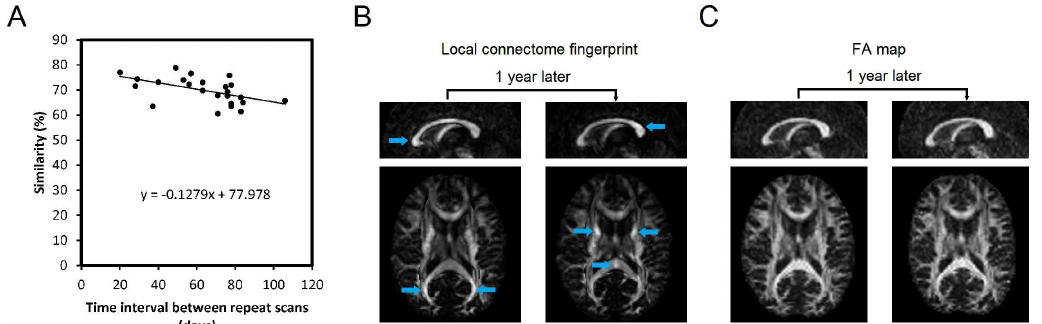
Fig 5. Neuroplasticity revealedby the local connectome fingerprint. (A) A scatter plot showinga decreasing trend in similarity against time in dataset II. (B) The local connectomefingerprint from one subject in dataset IV shows substantial differences between repeat scans. The changes includeboth increasedand decreasedconnectivity at different locations, leadingto a drop in the self-similarity. The fact that these changes are located at specific white matter bundles suggests that they are unlikely due to an image artifact. (C) The FA map calculated from the same data shows no obvious difference between repeat scans. There is no visible trait of signal drift, motion artifact or coil degradation, confirming the quality of the image acquisition.